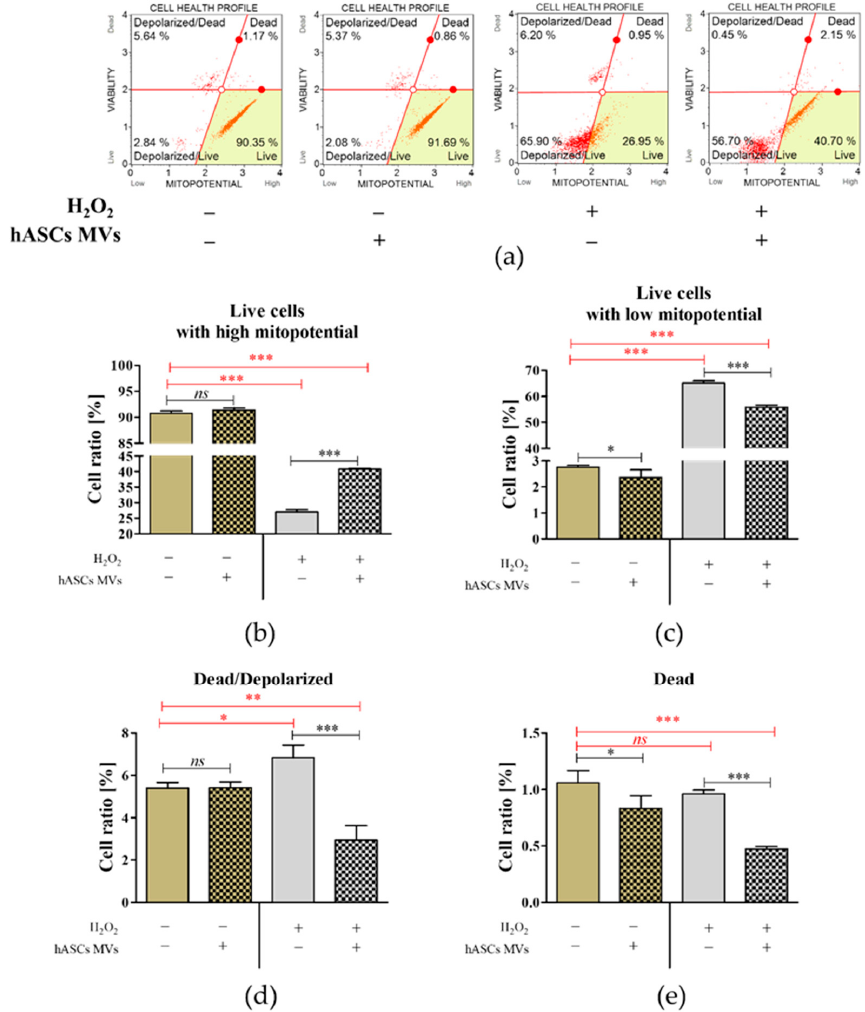
Figure 4. The influence of MVs on mitochondrial membrane potential in CaMLCs cultures both under normal and oxidative stress conditions induced using H 2 O 2 . The analysis was performed using the Muse ® Mitopotential Assay Kit. The representative graphs ( a ) show gated cells with quadrant marker providing data on four cell populations—live cells with depolarized mitochondrial membrane (lower left quadrant), live cells with intact mitochondrial membrane (lower right quadrant), dead/depolarized cells (upper left quadrant) and dead cells (upper right quadrant). The analysis was performed in triplicate, and the comparative statistic was performed ( b – e ). An asterisk marks a statistically significant di ff erence (* p ≤ 0.05; ** p ≤ 0.01 and *** p ≤ 0.001). Di ff erences between healthy cultures and cultures with induced oxidative stress are marked with red font. The results are expressed as mean ±